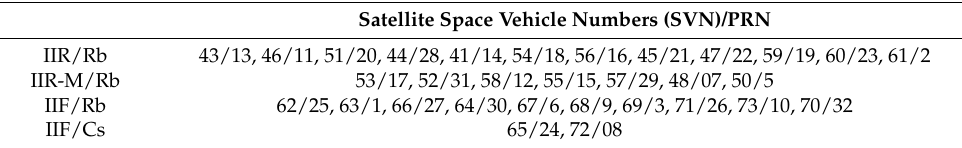
Table 3. Block type, PRN and clock type of GPS (up to 18 April 2017).